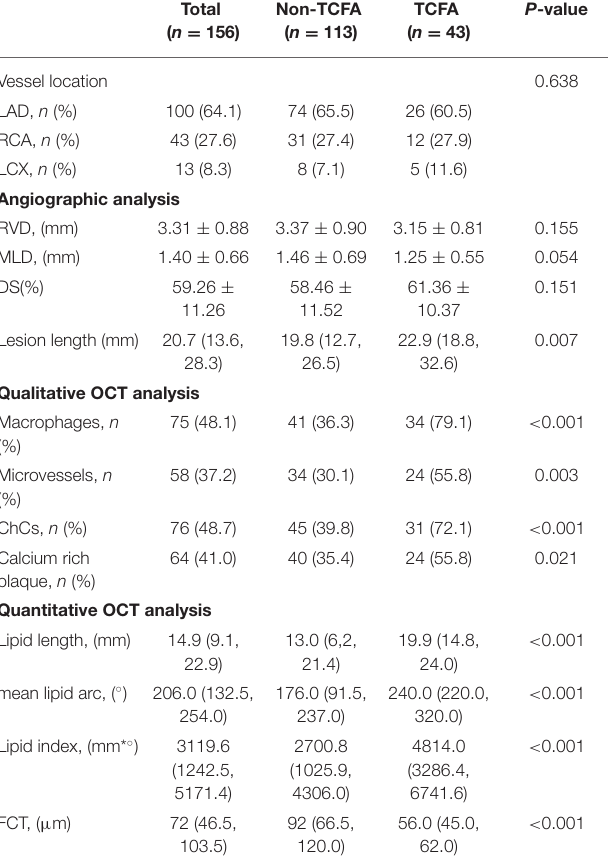
TABLE 2 | Angiographic and optical coherence tomography (OCT) analysis. TABLE 3 | Univariate and multivariate logistic regression model for prediction of